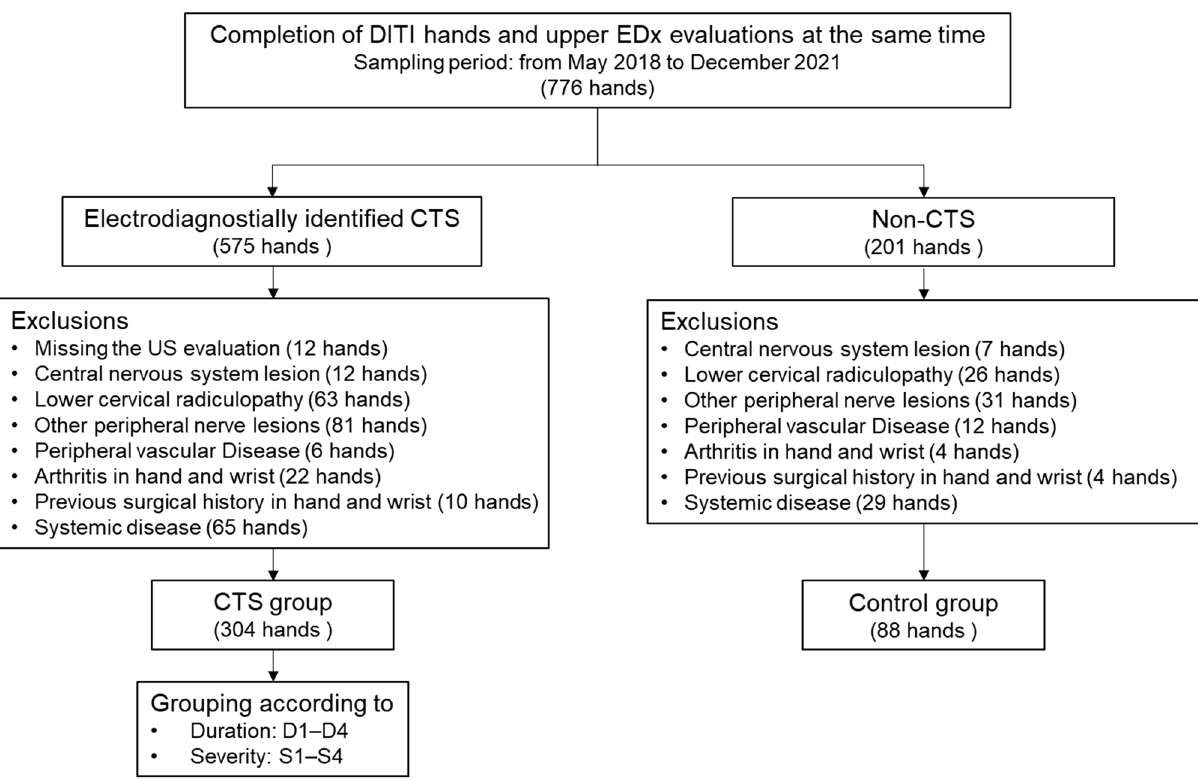
Figure 1. Flow chart of the patient selection process. DITI digital infrared thermography, EDx electrodiagnosis, CTS carpal tunnel syndrome, US ultrasonography, D symptom duration group, S severity